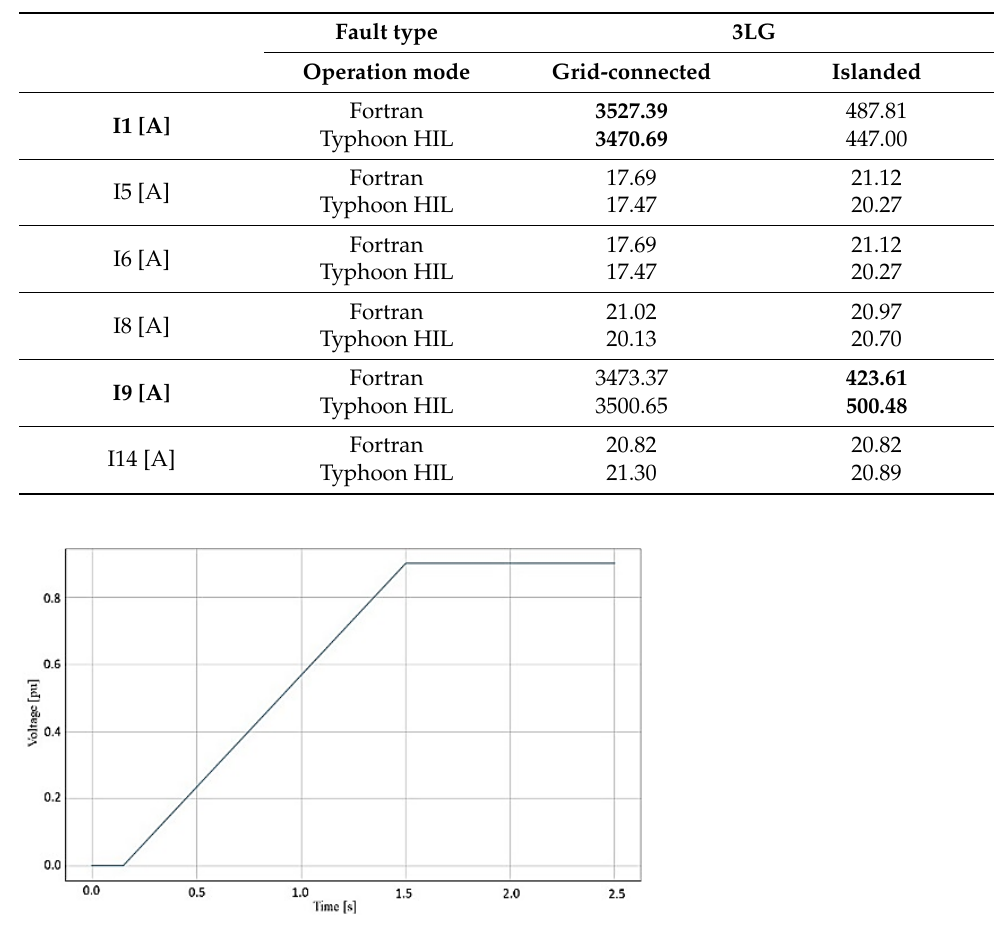
Figure 8. FRT requirements from German grid code standard. The results for the complete faulted states of the microgrid in grid-connected and 396 respectively.